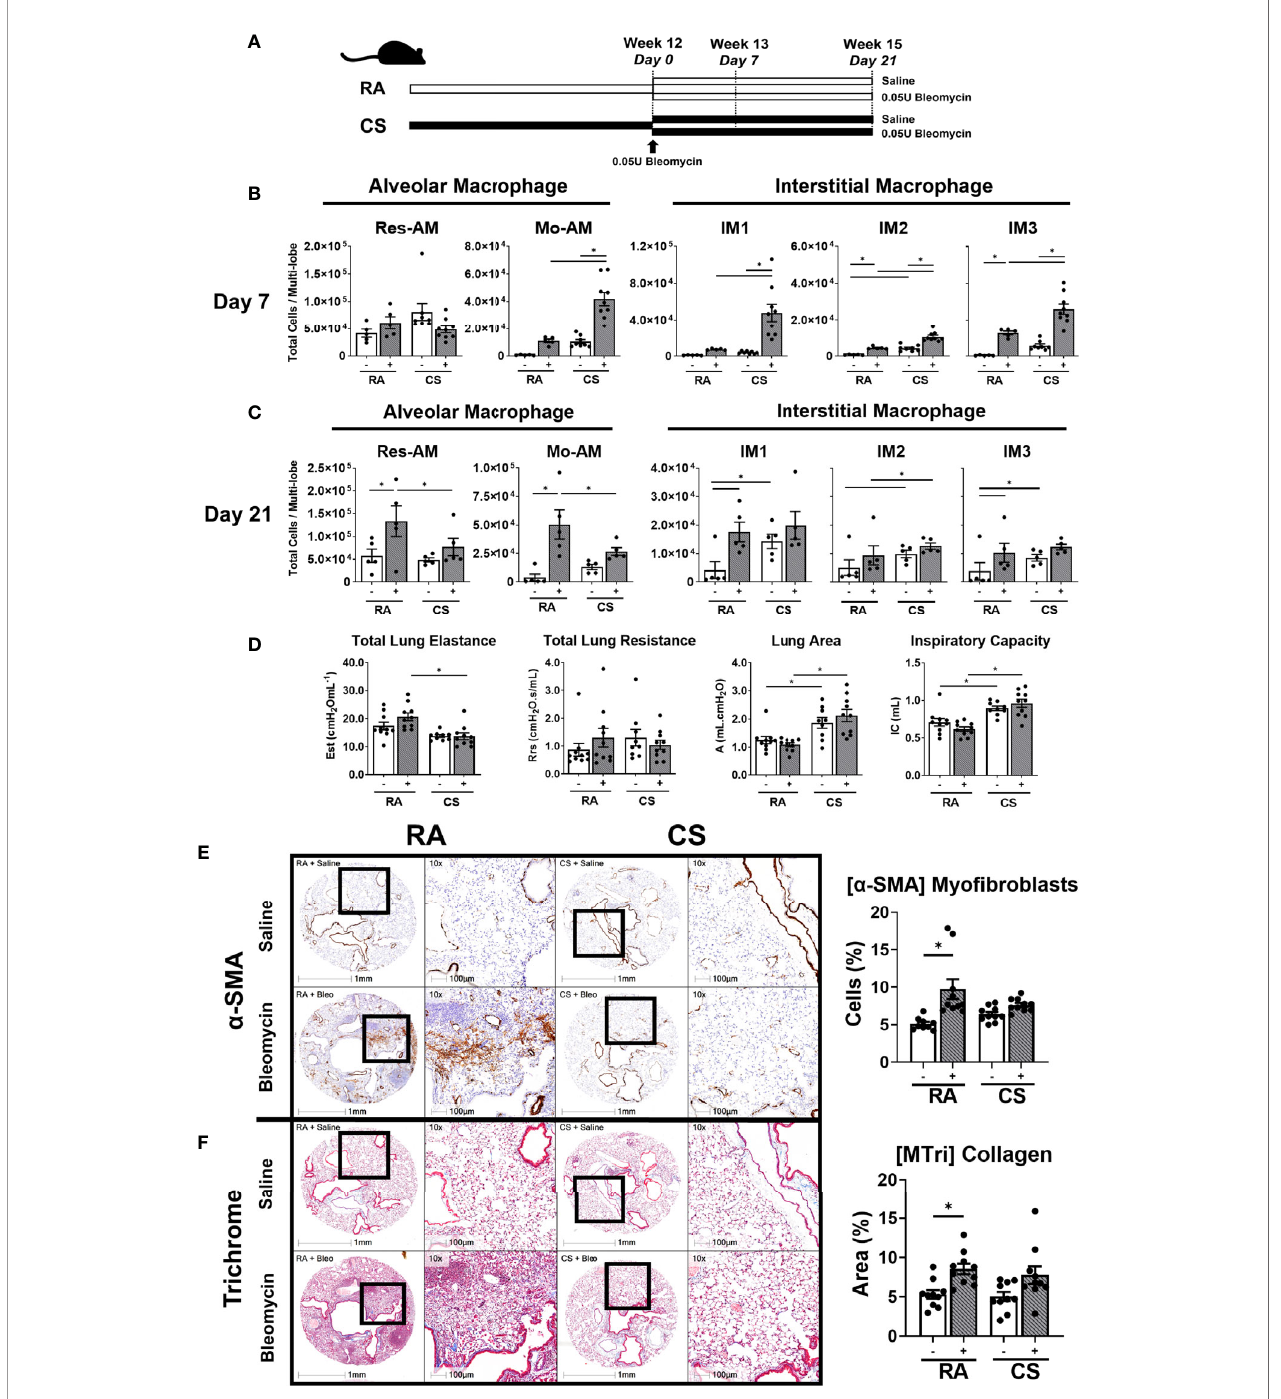
FIGURE 5 | Skewed macrophage subpopulation composition is associated with decreased fi brogenesis. (A) Schematic of CS exposure with bleomycin instillation. C57BL/6 female mice were administered bleomycin (0.05U/mouse) (grey bars) or saline control (open bars) following 12-weeks of RA or CS exposure. Res-AM, Mo- AM, IM1, IM2, and IM3 populations in lung tissue following (B) 7 days or (C) 21 days of bleomycin administration. (D) Functional parameters derived from the pressure-driven pressure – volume loops included: total lung elastance, total lung resistance, lung area (atelectasis) and inspiration capacity measured at day 21. Data show representative image and HALO quanti fi cation for (E) a -SMA and (F) Masson ’ s trichrome. Data show mean ± SEM, n = 5 - 10. Two-way ANOVA with Tukey ’ s multi-comparison test. Est, elastance; Rrs, resistance; A, area; IC, inspiration capacity; RA, room air; CS, cigarette smoke. *p < 0.05. “ - ” represents saline administration. "+" represents 0.05U bleomycin